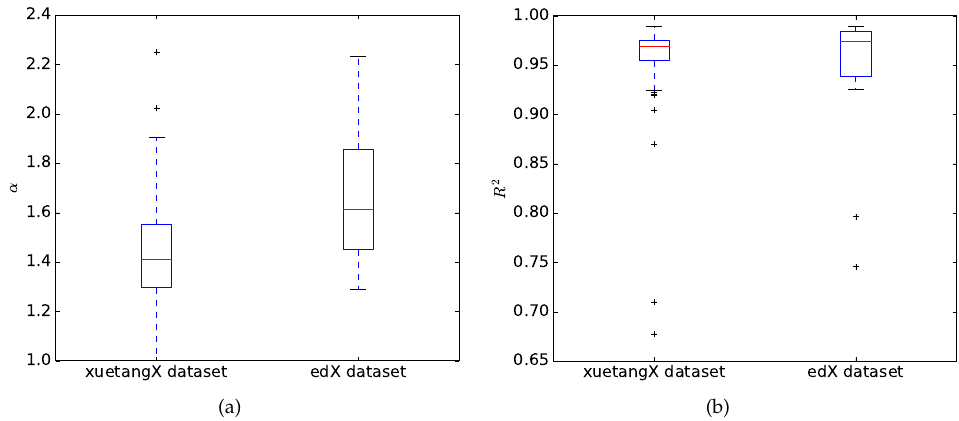
Figure 5. Linear regression results: ( a ) The exponent parameter α ; ( b ) The R-squared